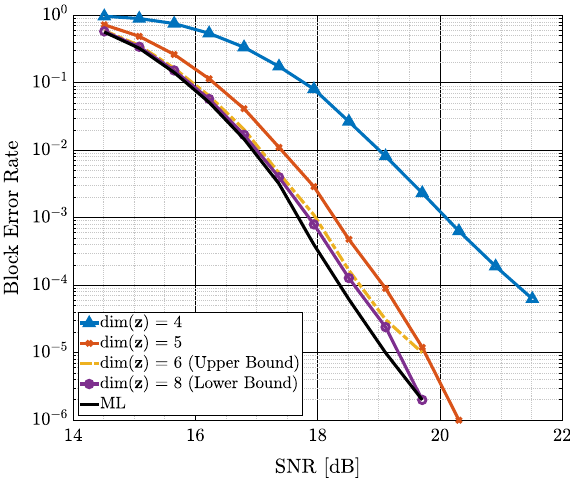
Fig. 5 Impact of latent feature dimension on different instances of EQ-Net without numerical quantization in an i.i.d. Rayleigh fading, 2 × 2 , 64-QAM scenario using an (324, 648) LDPC code. A feature dimension of six corresponds to the upper bound in Theorem 2, which is proven explicitly for diagonalized channels, but is shown here to be practically achievable for arbitrary